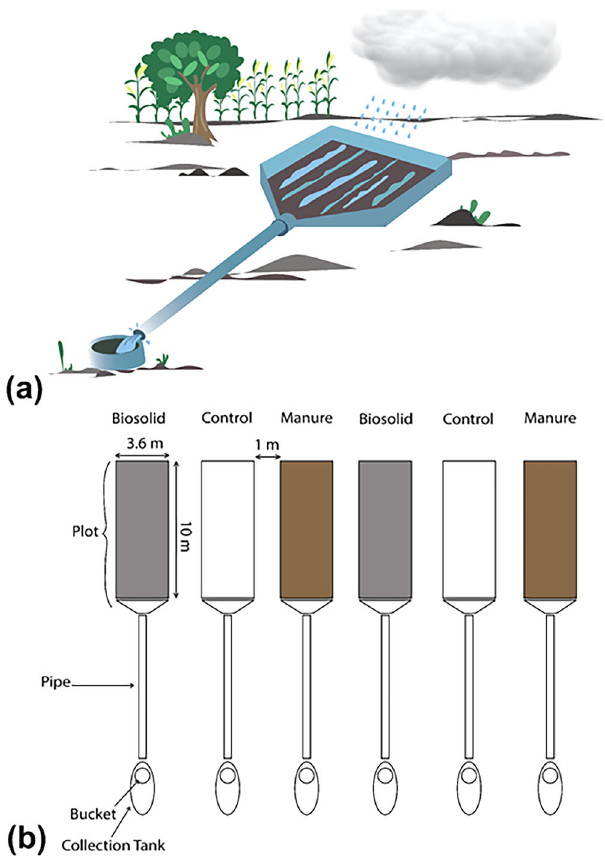
Fig. 8 Illustration and schematic of the constructed plots. Panel ( a ) is the illustration of the constructed plots that were located at Rogers Memorial Farm, Lincoln, Nebraska. Panel ( b ) shows the schematic of the constructed plots. Galvanized aluminum collection buckets were placed inside the collection tanks below the pipe, and grab samples were taken from the buckets. The contents of the buckets were added to each tank and the total collected runoff volume from each plot was